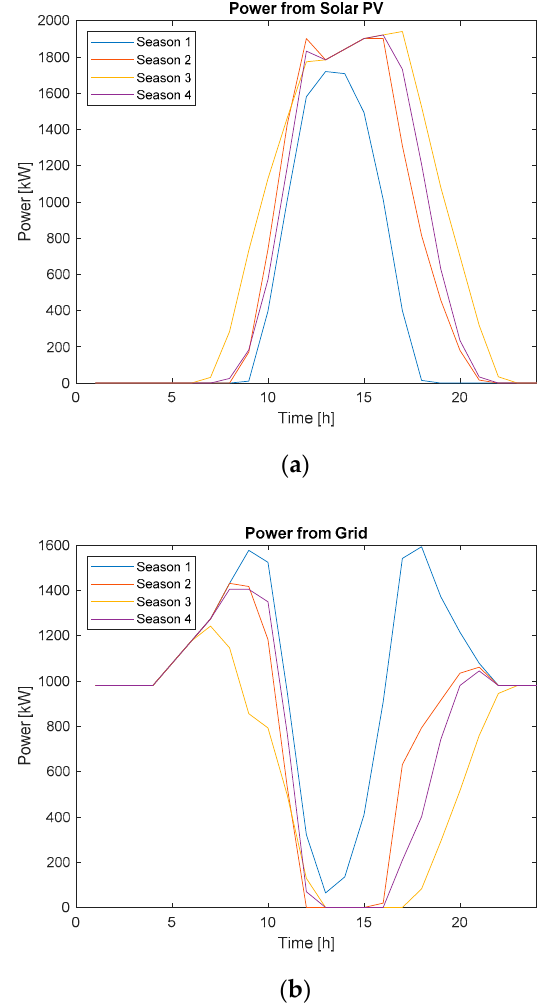
Figure 4. ( a ) Solar PV power from a 4888.98 kW system; ( b ) power from the grid for solar PV and grid power case.